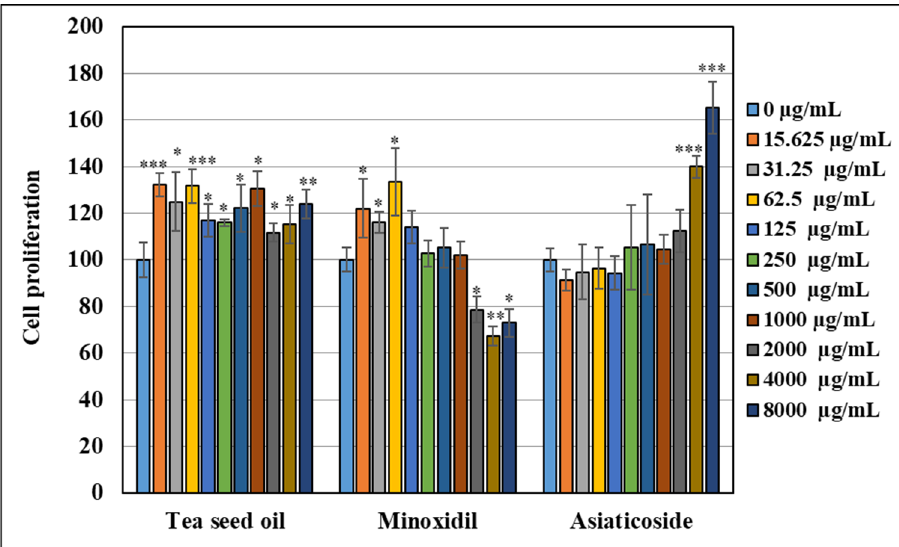
Figure 2. Cytotoxicity and cell proliferation of HFDP cells treated with tea seed oil compared to minoxidil and asiaticoside. (* indicates statistical significance at p < 0.05, ** indicates statistical significance at p < 0.01, *** indicates statistical significance at p < 0.005).